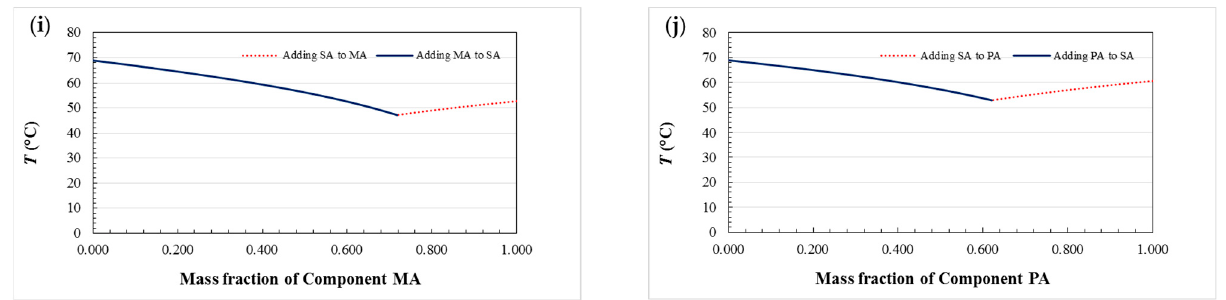
Figure 3. Phase diagram of ten fatty acid binary eutectic mixtures ( a ) CA–LA, ( b ) CA–MA, ( c ) CA–PA,